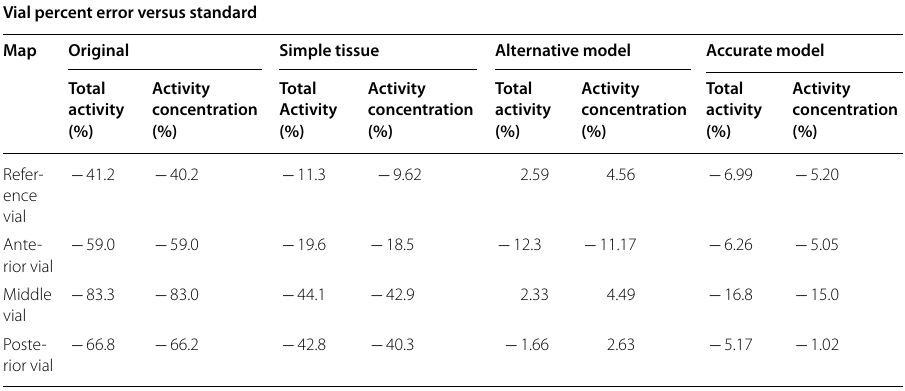
Table 4 Percent errors of the individual total vial activities and activity concentrations compared to the gold standard Vial percent error versus standard Map